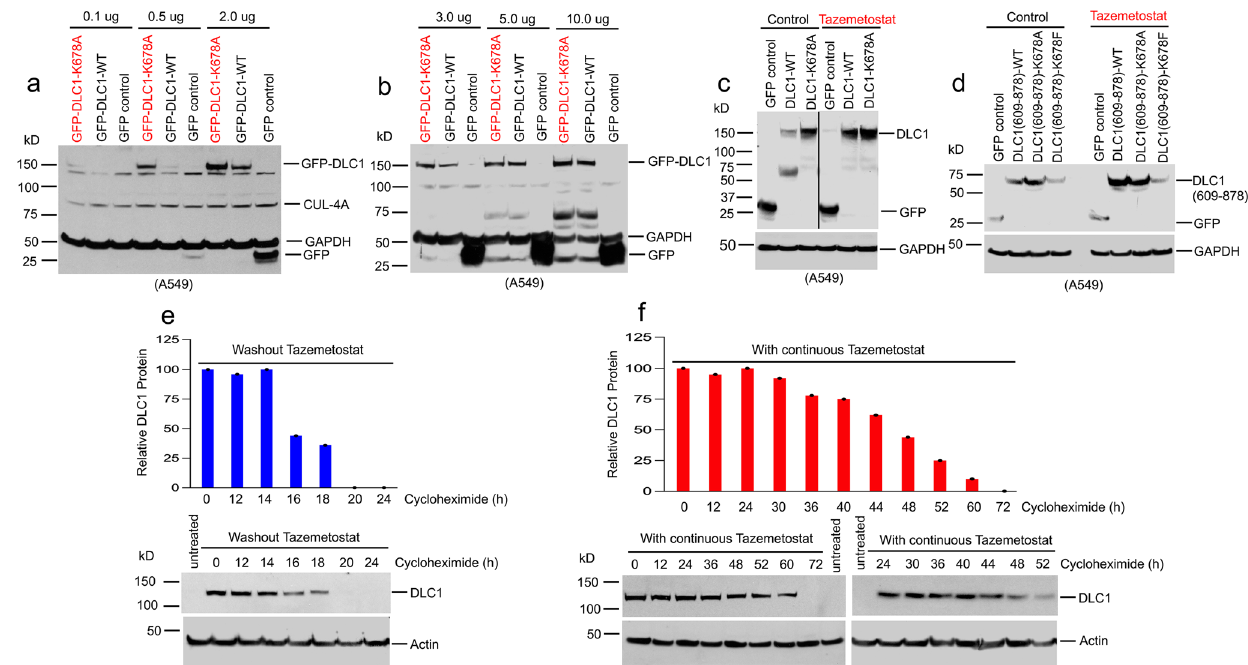
Fig. 9 Methylation of DLC1-K678 decreases the steady-state level of DLC1 protein; EZH2 inhibition decreases DLC1 protein turnover. a , b A549 cells were transiently transfected with different amounts of cDNAs encoding GFP, GFP-tagged DLC1-WT, and GFP-tagged DLC1-K678A mutant. a At low amounts (0.5 – 2.0 μ g) of cDNA, DLC1-K678A mutant protein levels were substantially higher than DLC1-WT levels. b At higher amounts (5.0 – 10 μ g), the difference between DLC1-WT protein and DLC1-K678A was reduced. c , d Tazemetostat treatment increased the steady-state level of DLC1-WT and DLC1(609-878)-WT but had a marginal effect on the DLC1-K678A, DLC1(609-878)-K678A methylation-de fi cient mutants, or the DLC1(609-878)-K678F methylation mimetic mutant. Two independent experiments were performed for a – d with similar results. e , f Tazemetostat treatment increases DLC1 protein half-life. Cell lysates were analyzed for DLC1 and actin by western blotting, and the relative density of DLC1 was plotted against time after treatment with cycloheximide. In the absence of Tazemetostat, DLC1 protein half-life is <2 h (18 h vs. 20 h) ( e ). However, in the presence of Tazemetostat, DLC1 protein half-life is ~48 h (0 h vs. 48 h) ( f ). Graphs show the relative DLC1 protein level at the indicated time points after cycloheximide treatment. Source data are provided as a Source Data fi